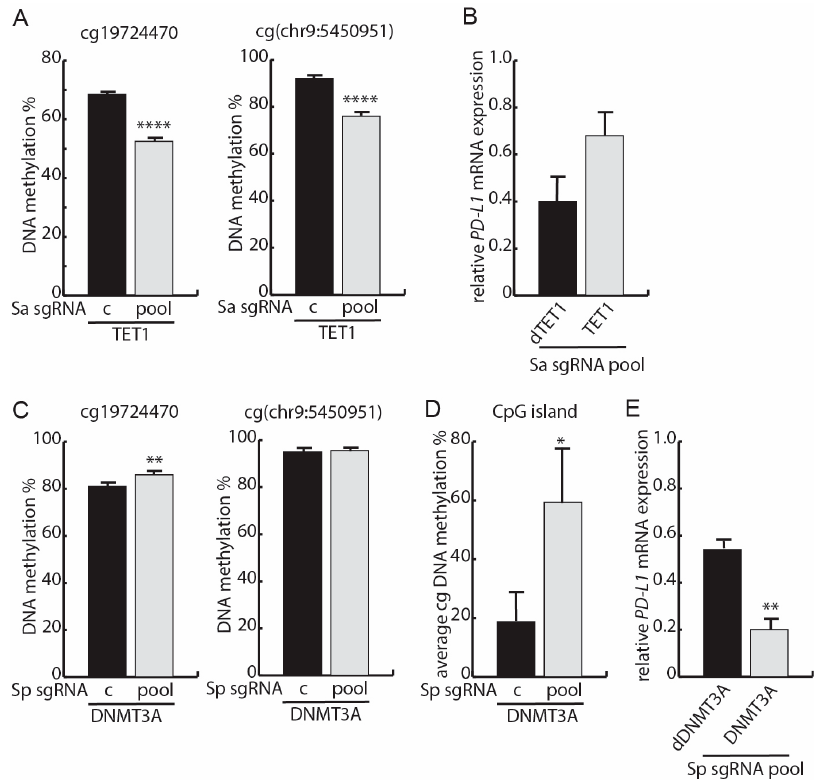
Figure 4. Effects of dCas9-fusion-mediated specific targeting of PD-L1 methylation and demethylation. ( A ) HEK293T-dSaCas9-TET1 cells were induced with doxycycline and transfected with Streptococcus aureus (Sa) control sgRNA (c) or a pool of Sa sgRNAs (pool) targeting the south shore of the PD-L1 CpG island. Next, 48 h after transfection, DNA methylation was analyzed and presented as mean ± SD. n = 3. One-way ANOVA with Holm–Šid á k’s multiple comparisons test was used to test for significant differences in DNA methylation. ( B ) Relative PD-L1 mRNA expression in dSaCas9-TET1 and dSaCas9-dTET1 cells transfected with the Sa sgRNA pool. The expression is shown relative to the values obtained with the Sp sgRNA control and normalized to TBP